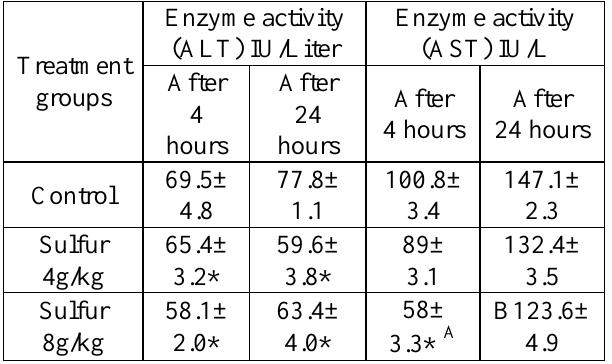
Table 2: Sulfur effects on ALTandAST activity in mice: